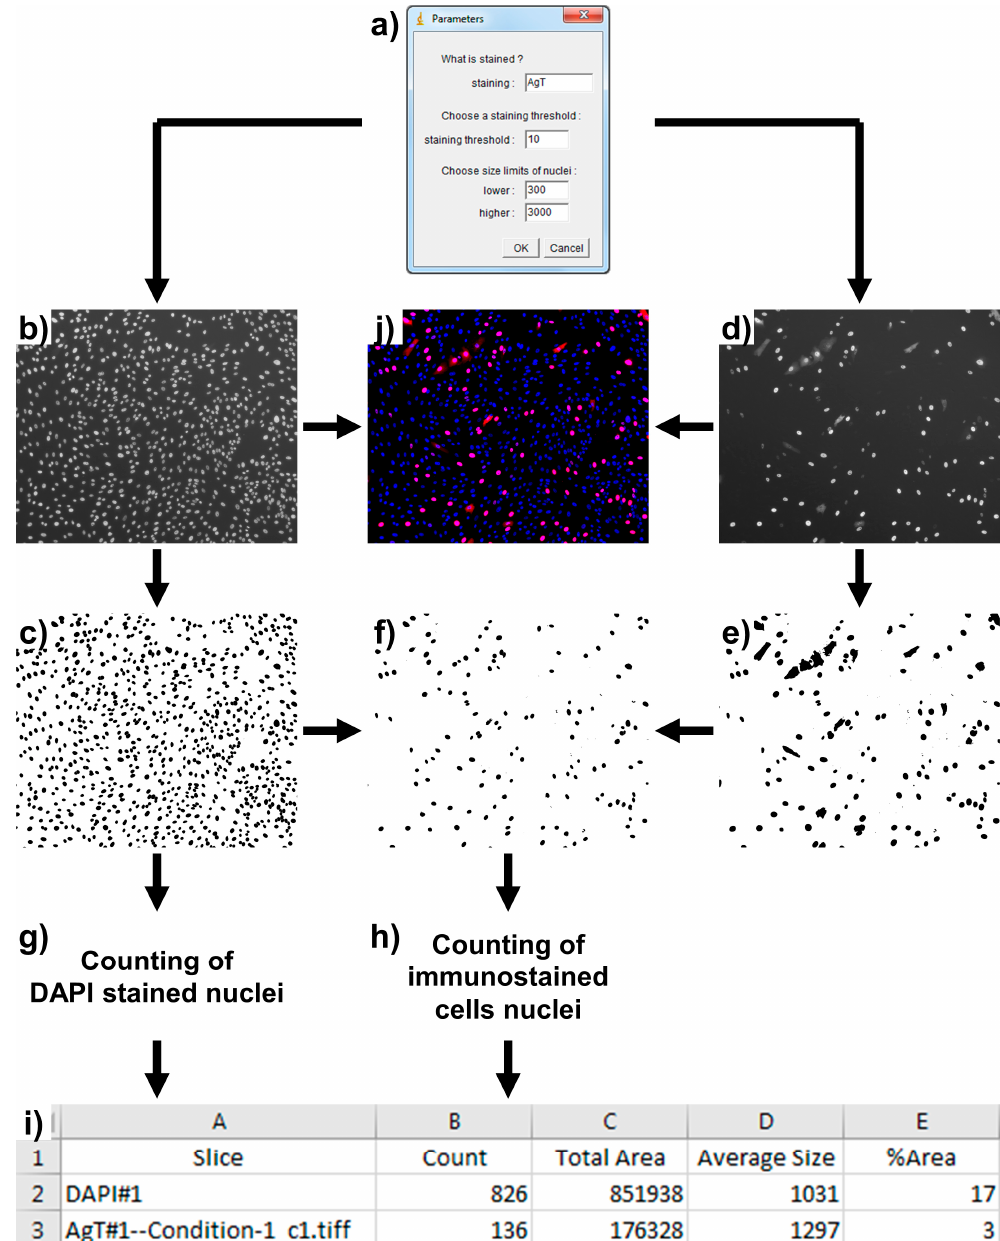
Figure 1. Description of the QuantIF macro. After entering the parameters into the dialog box ( a ), two images of each field are analyzed. The DAPI staining image ( b ) is converted to a DAPI staining mask ( c ), and the specific staining image ( d ) is converted to a specific staining mask ( e ), by implementing the Huang’s fuzzy thresholding method. A third mask corresponding to the nuclei of the immunostained cells is created using the “Image Calculator” command and the “AND” operator ( f ). Finally, DAPI stained nuclei and immunostained cell nuclei are counted using the “Analyze Particles” tool ( g , h ). After processing, the numbers of DAPI-stained nuclei and immunostained cell nuclei for each condition are saved as a “.xls” file in the folder that has been analyzed ( i ). A merge of the DAPI and specific staining images is shown for informational purposes ( j ).